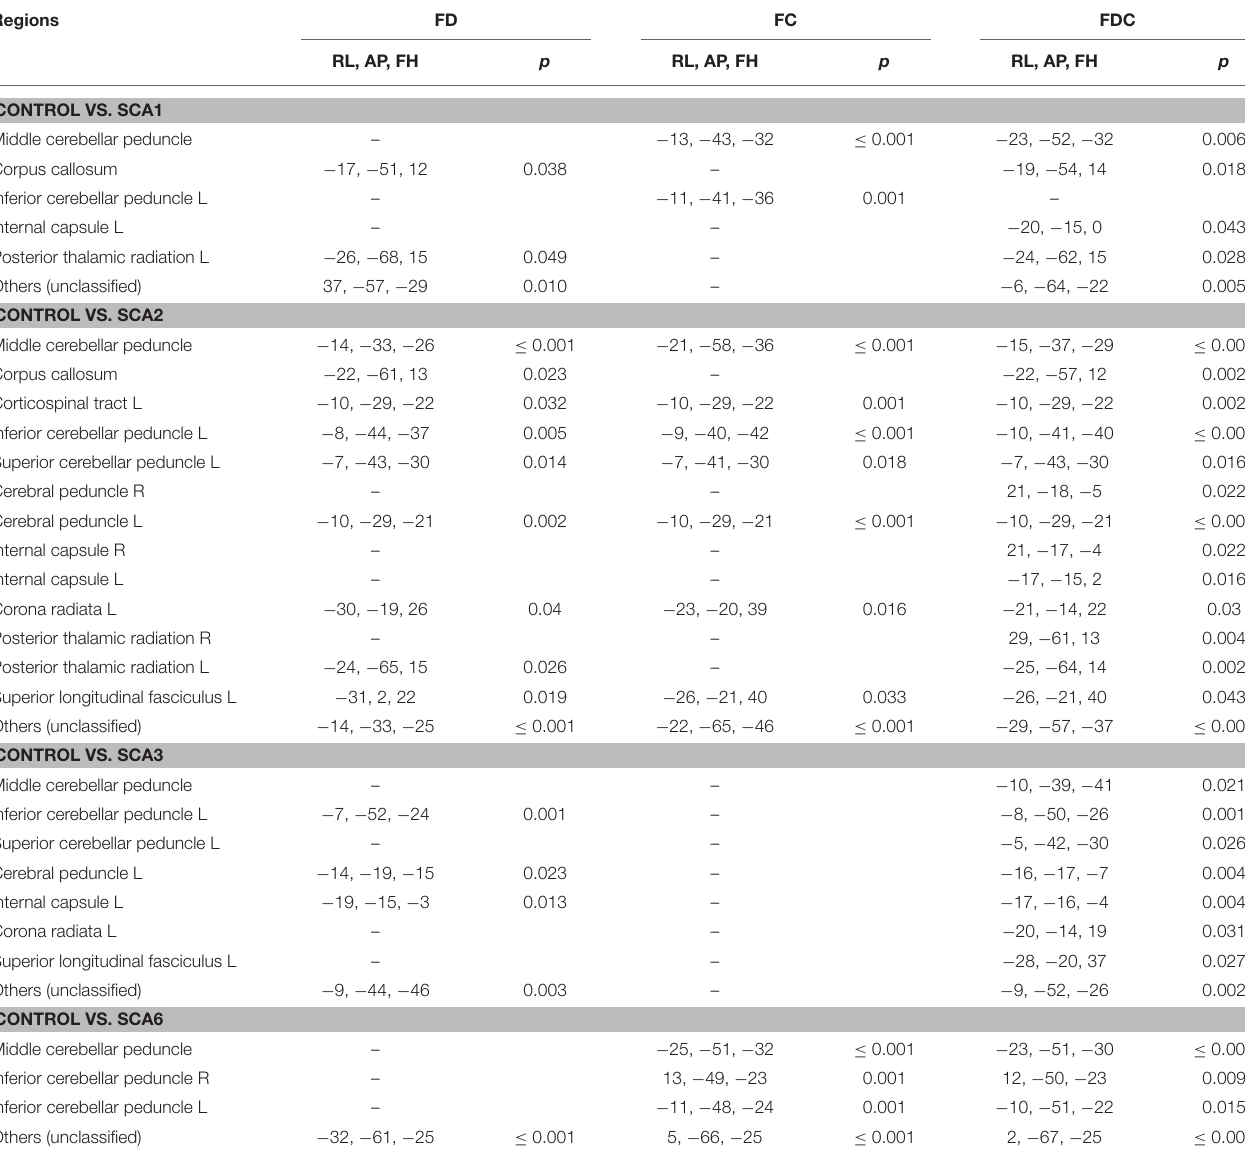
TABLE 2 | Neuroanatomical regions showing significantly lower FD, FC, and FDC metrics in SCA1, 2, 3, and 6 cohorts than healthy controls.